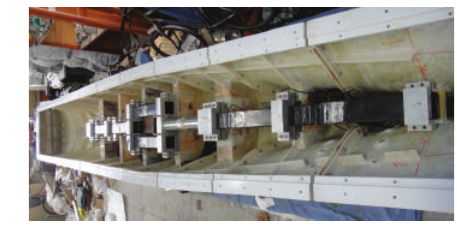
Figure 2: Backbone system.